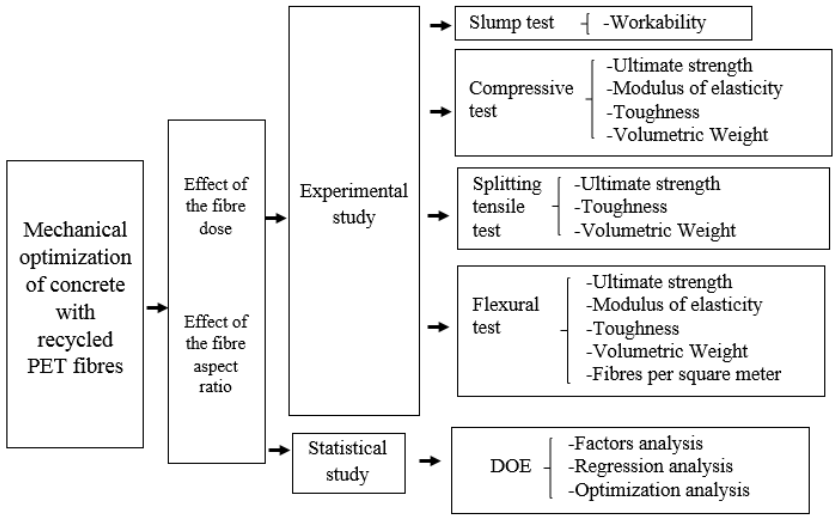
Figure 1. Tests considered in the experimental